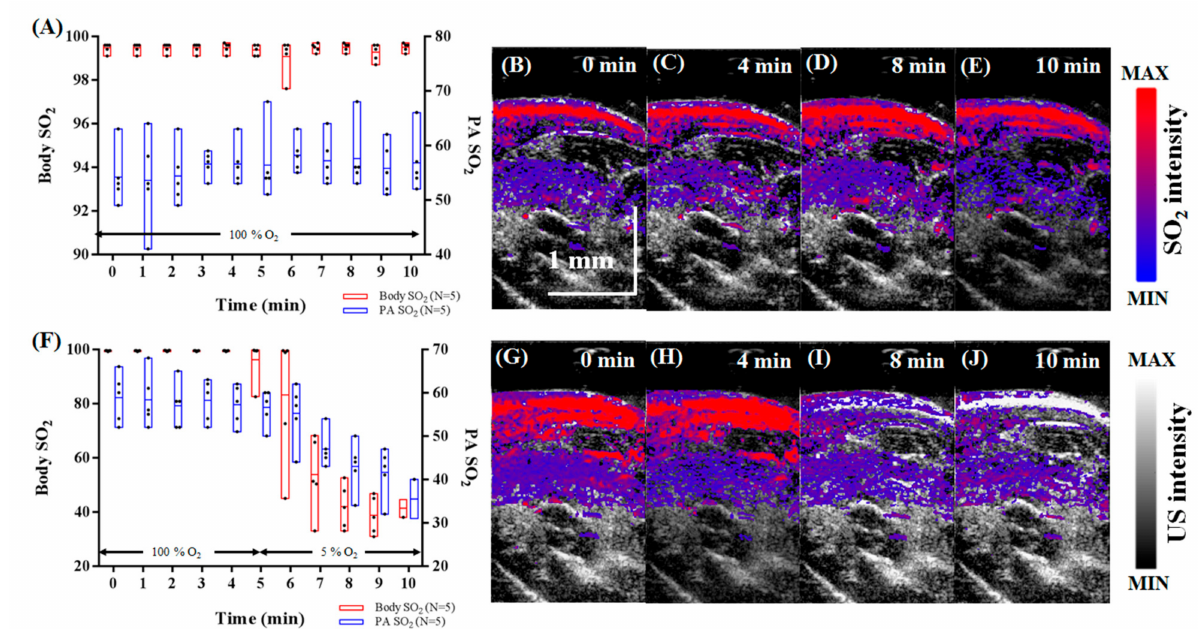
Figure 4. Dynamic changes in SO 2 during a controlled hypoxia challenge. ( A ) Changes in body and PA SO 2 as inhaled gas was maintained at 100% O 2 . ( B – E ) Representative PA images collected over 10 min showing tissue oxygen distribution in the hindlimb were overlaid with US images. ( F ) Changes in body and PA SO 2 as inhaled gas was switched from 100% O 2 to carbogen at the 5 min mark to induce hypoxia. ( G – J ) Representative PA/US images collected during hypoxia challenge (N = 5; * p <